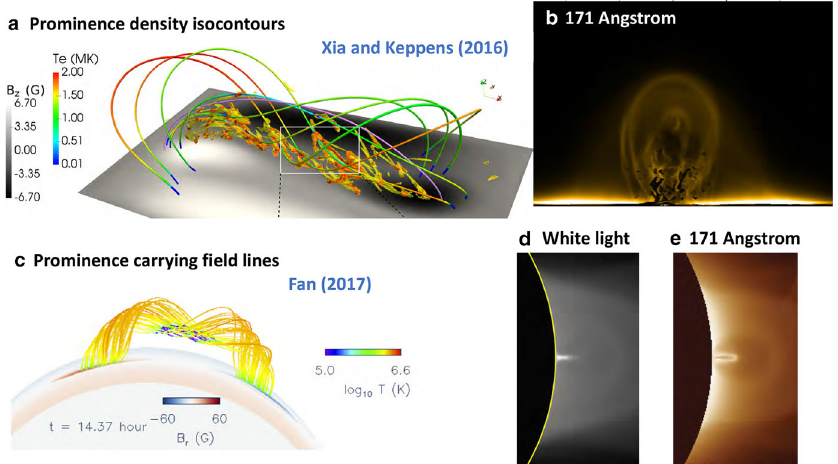
Fig. 20 Simulations in which prominences dynamically form within 3D magnetic structures (left) a Xia and Keppens (2016) and c Fan (2017) sample magnetic field lines with cool, dense prominence plasma supported in dips; (right) Synthetic observations of prominence material in absorption surrounded by a coronal cavity from b Xia and Keppens (2016) and d a simulation similar to Fan (2017) that was presented in Gibson et al. (2016). Images reproduced with permission, a – c copyright by